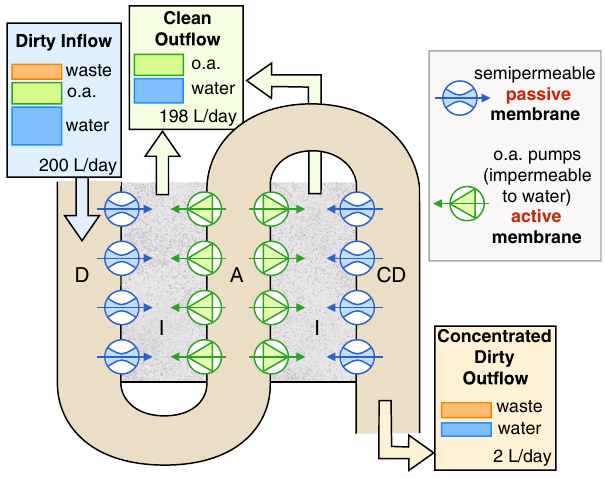
FIG. 1. The osmotic exchanger filtration system. Model for a concentrating device based on the geometry of Henle ’ s loop in the kidney. Water, waste, and salt are carried through the loop of Henle, consisting of the descending limb (D) and ascending limb (A) and continued by the collecting duct (CD). Each limb wall allows exchanges with the interstitium (I), enabling water and salt to evacuate the loop. The remaining waste is concentrated and evacuated by the